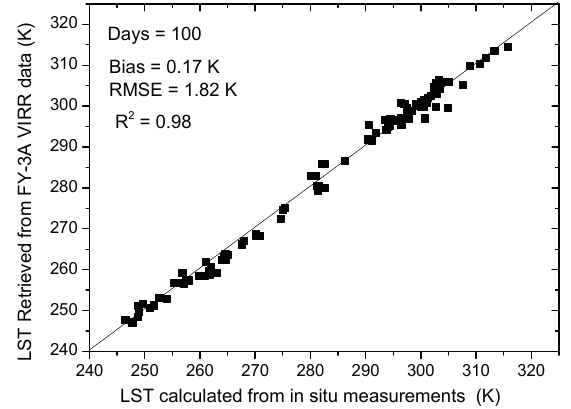
Figure 13. Comparison between the LSTs estimated using the proposed method and those calculated using in situ measurements for cloud-free conditions at the time of the FY-3A VIRR overpass during the experiment period at the Hailar site (R 2 is the square of the correlation